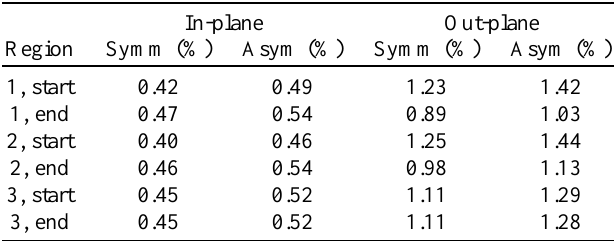
TABLE II. Maximum fractional quad strength excursions,